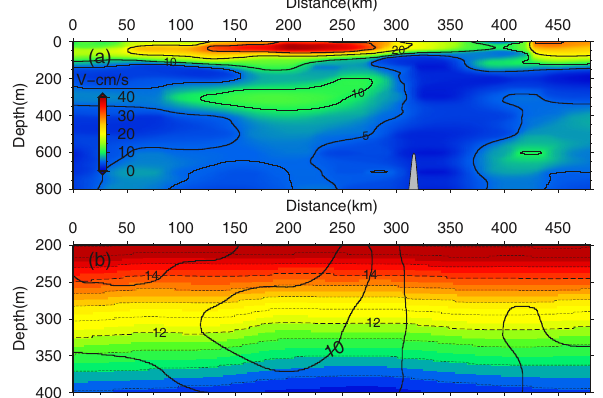
Fig. 6. Vertical sections of the HYCOM simulated current speeds (a) and temperature ( b ) along the seismic transect. Speeds contours in (a) are also superimposed in (b)